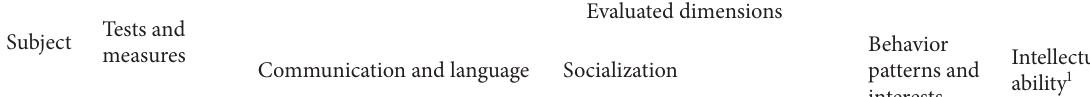
Table 3: Summary results of the comparative behavioral evaluation of TWO and